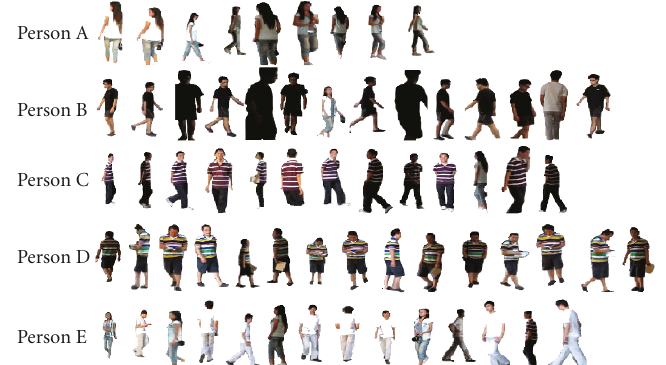
Figure 20: Trajectories recovered by EM with forward appr.II inference initialized by K-means clustering.